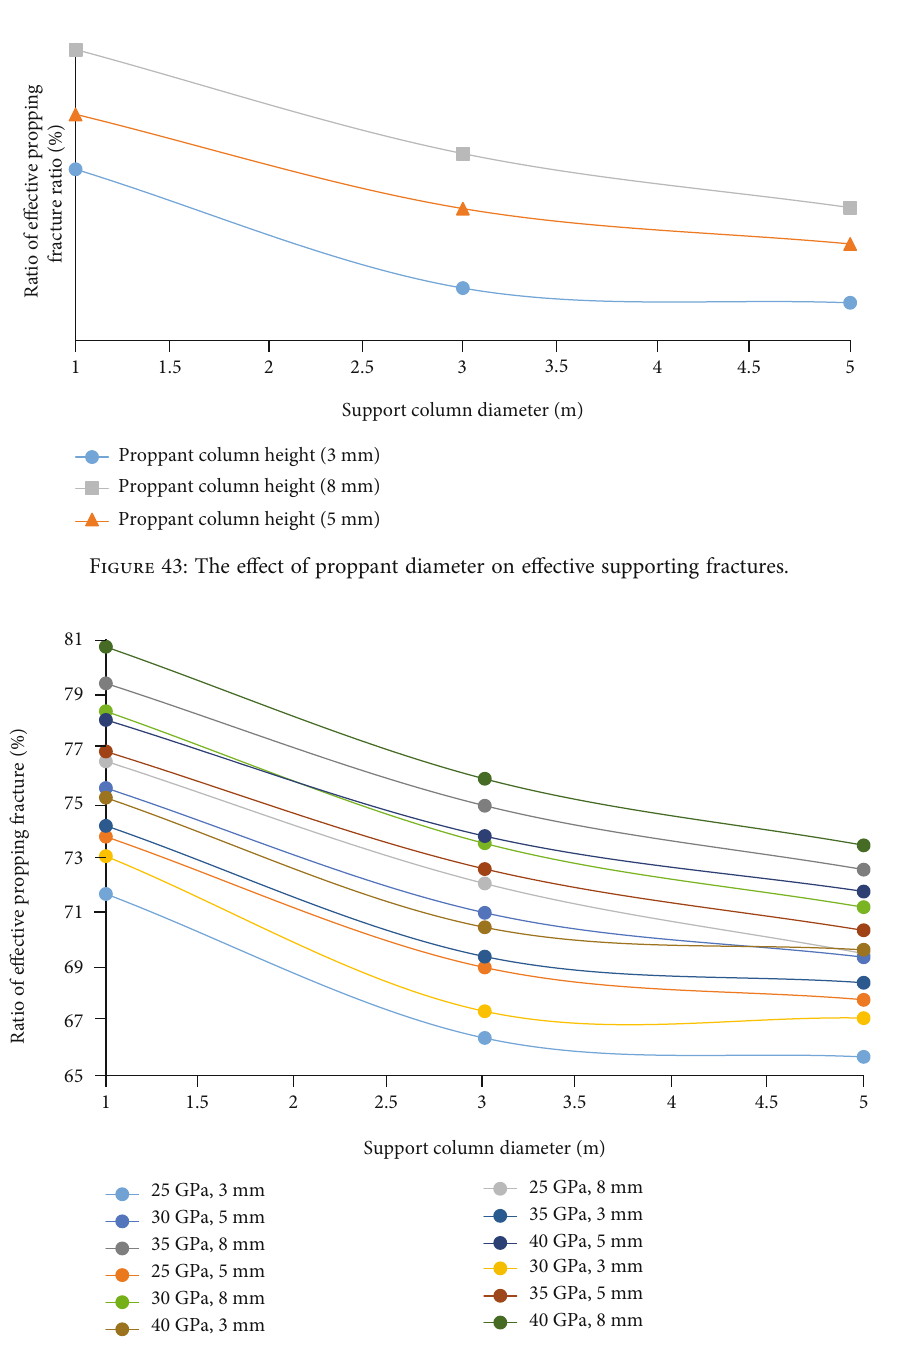
Figure 44: The e ff ect of proppant diameter on the ratio of e ff ective supporting fractures (in situ stress 40